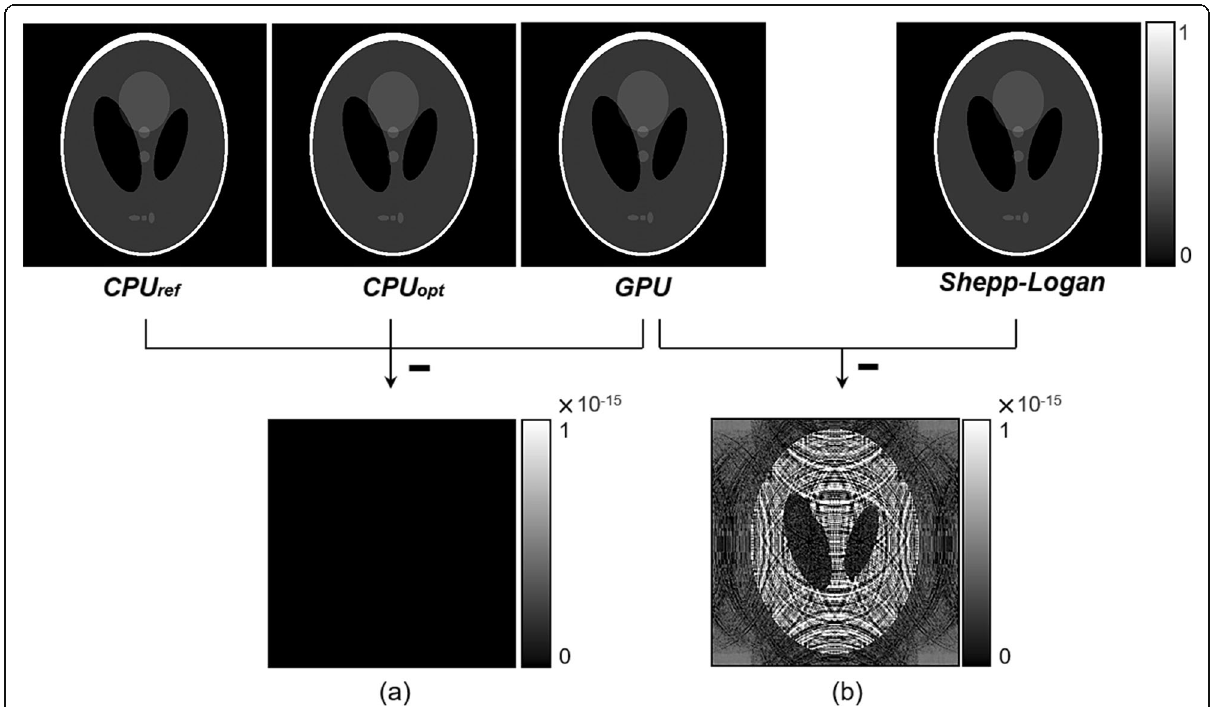
Fig. 3 Reconstruction performance of the sinc function with respect to each implementation at 384 × 384. a The GPU-computed image is subtracted from CPU-computed reconstructed images. b There is no RMSE with respect to the CPU images. Subsequently, the difference image is obtained by subtracting the GPU image from the Shepp – Logan image. Reconstruction errors are observed; however, the corresponding values (RMSE = 1.58 × 10 − 15 ) are considered as 0.0 in digital